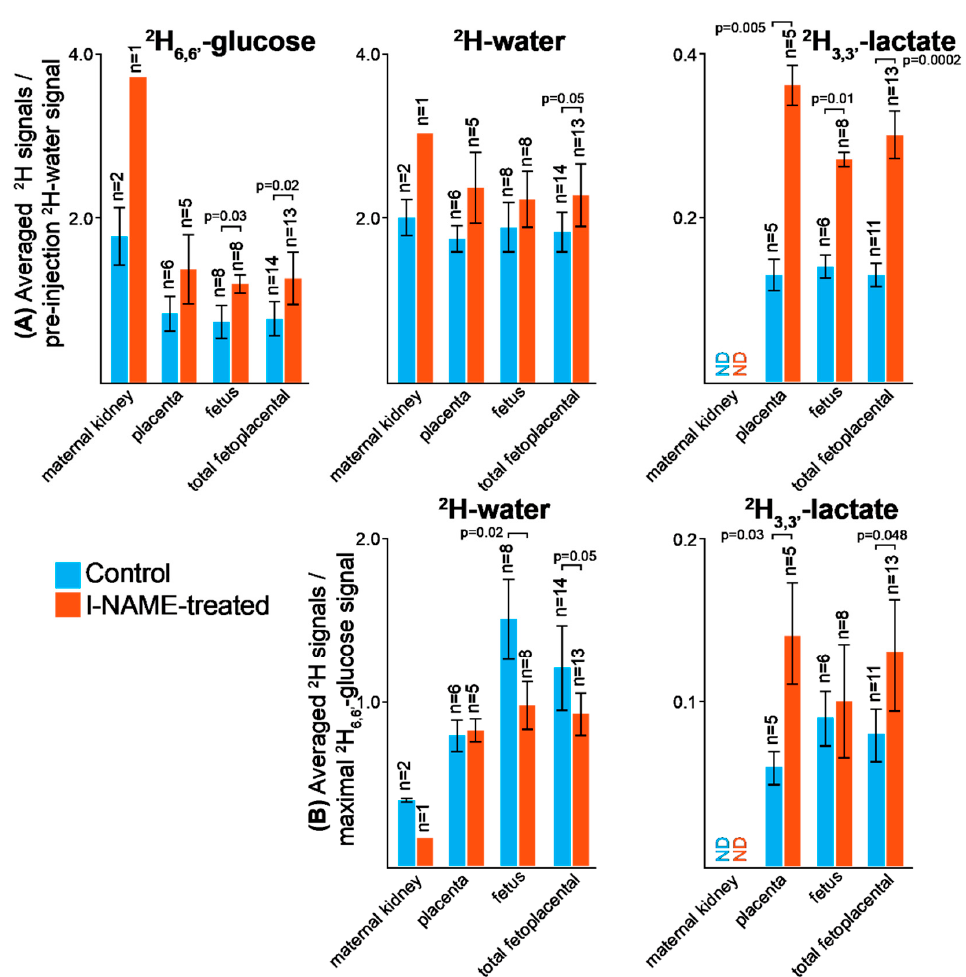
Figure 4. Summary and statistics for the uptake and the generation of various metabolites in maternal and fetal organs, highlighting salient aspects of the experiments run in this study (Supplementary Figures S3–S11 and S15–S23). Both panels focus on glucose, water or lactate signals averaged over the entire time course of the experiment, i.e., if 10 images were taken over a 125 min experiment, what is shown are the sum of the corresponding peak images as mapped for each organ, divided by 10. ( A ) Average signals normalized according to the image intensity observed in each organ for the pre-injec- tion 2 H-water peak, for the control and l-NAME-treated animals. This gives an idea of the maximum absolute levels reached by each metabolite in each organ. ( B ) Idem as ( A ) but upon normalizing the water and lactate 2 H images by the maximum 2 H 6,6 ′ -glucose signal observed in the animals’ organs. This conveys an idea of glycolytic activity, independent of the glucose injection details. Error bars indicate standard deviations of the measurements for the indicated regions; notice that because of limited spatial resolution, all the fetal organs (brain, liver, heart) are here pooled in the “fetus” category. Indicated as well are p -values calculated from paired, two sample t-tests assuming unequal variances, distin- guishing uptake/activity in control vs. preeclamptic mice for the various metabolites; only significant differences ( p ≤ 0.05) are noted. ND: non-detectable. 2.3. Kinetic Analyses of the DMI Data In addition to the time-averaged assessment presented in Figure 4, kinetic time traces were analyzed for the full set of 2 H MRSI data collected over the whole animal cohorts making part of this study. Given the limitations of the collected 2 H MRSI data—foremost among these spectral sensitivity limitations that only allowed us to identify water and lactate as glucose’s metabolic products and spatial resolution limitations that limited our assessment of individual fetal organ—a simplified kinetic model was adopted. This model is akin to that usually employed to analyze metabolism in animal pregnancies utilizing radioactive tracers [55,56], and it considers (i) glucose ( G ) → lactate ( L ) and glucose ( G ) →